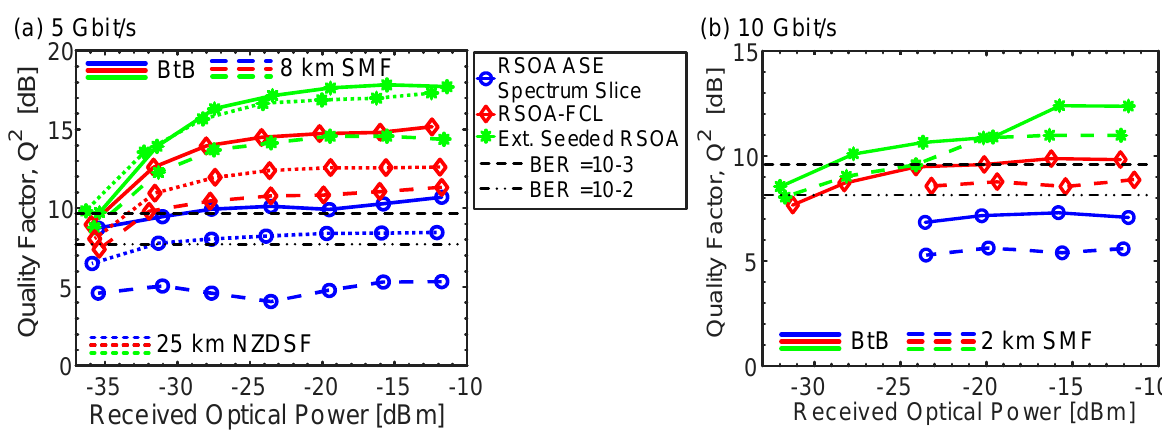
Figure 14. Measured quality factor Q 2 (dB) for transmission of ( a ) 5 Gbit/s and ( b ) 10 Gbit/s using the ASE spectrum-sliced scheme (blue), the self-seeded RSOA-FCL (red) and the externally seeded RSOA (green)